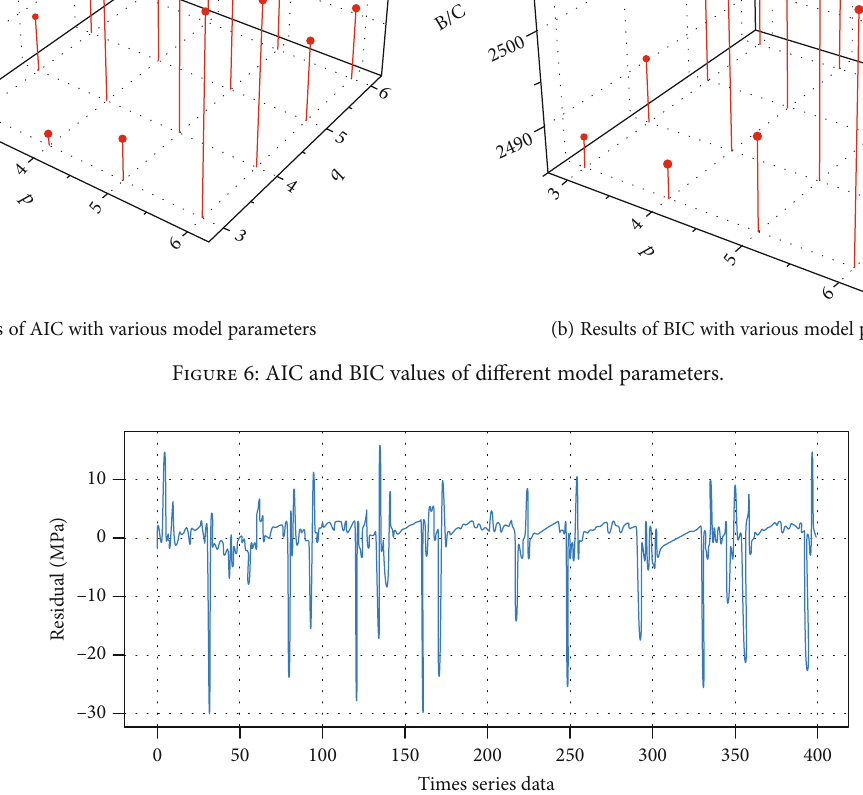
Figure 7: Residual value after optimizing the